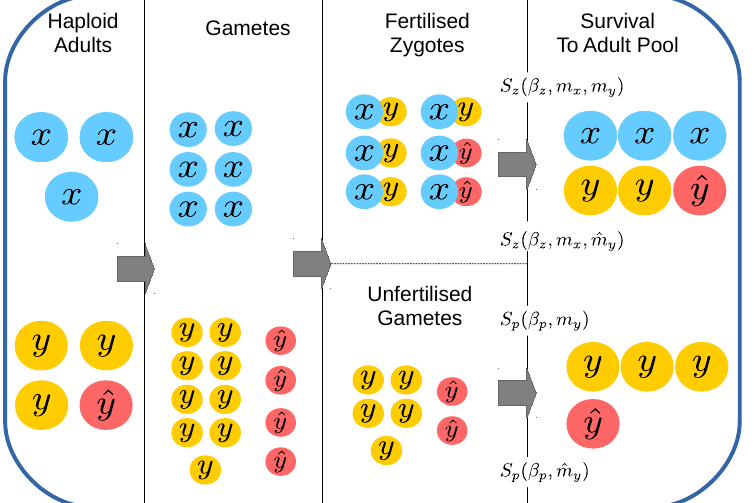
Figure 1. Schematic of Model. Haploid adults divide to form gametes at the start of a generation (see Section 2.1.1). Gametes of opposite mating types ( x and y ) fuse to form zygotes, while a number of gametes remain unfertilized in the zygote pool (see Section 2.1.2). Unfertilized gametes form parthenosporophytes, capable of parthenogenic development. Zygotes and parthenosporophytes survive according to to independent survival functions (see Section 2.1.3) to produce a number of haploid adults in the subsequent generation (see Section 2.1.4). Mutant mating types (here ˆ y ) produce gametes of a differing size to their ancestors, but inherit their self-incompatibility properties (see Section